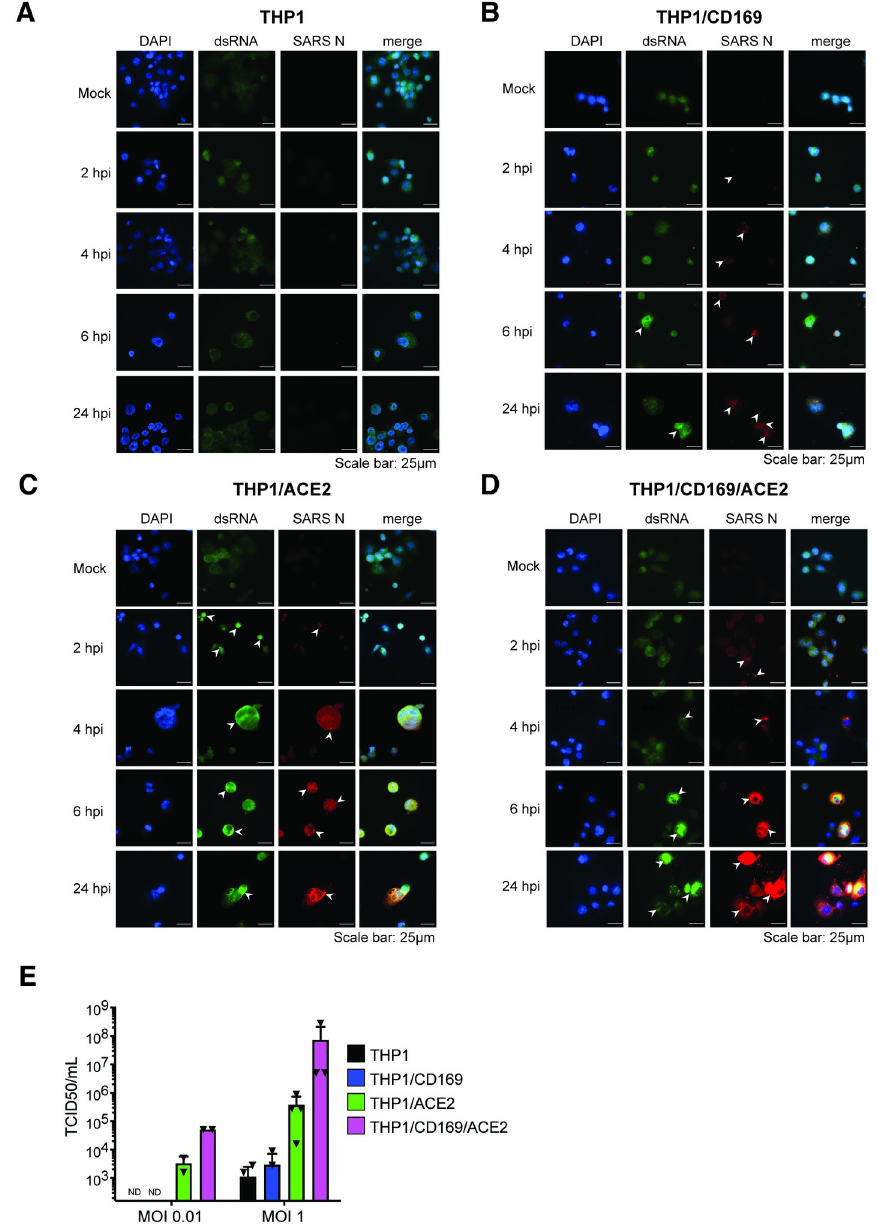
Fig 3. SARS-CoV-2 establishes abortive infection in CD169 + THP1/PMA macrophages. ( A - D ) Representative immunofluorescence images (100x) of THP1/PMA macrophages infected with SARS-CoV-2 (MOI = 1) and stained for nucleus (DAPI, blue), SARS-CoV-2 dsRNA (green), and SARS-CoV-2 nucleocapsid (N, red), at indicated times post infection. Images shown for each cell line; untransduced control (parental, A ), CD169+ ( B ), ACE2+ ( C ), and CD169+/ACE2+ ( D ). Bar = 25 μ m. ( E ) Culture supernatants from SARS-CoV-2 infected THP1/PMA macrophages were harvested at 24 hpi and viral titers determined by TCID 50 assay. The means ± SEM from 3 independent experiments are